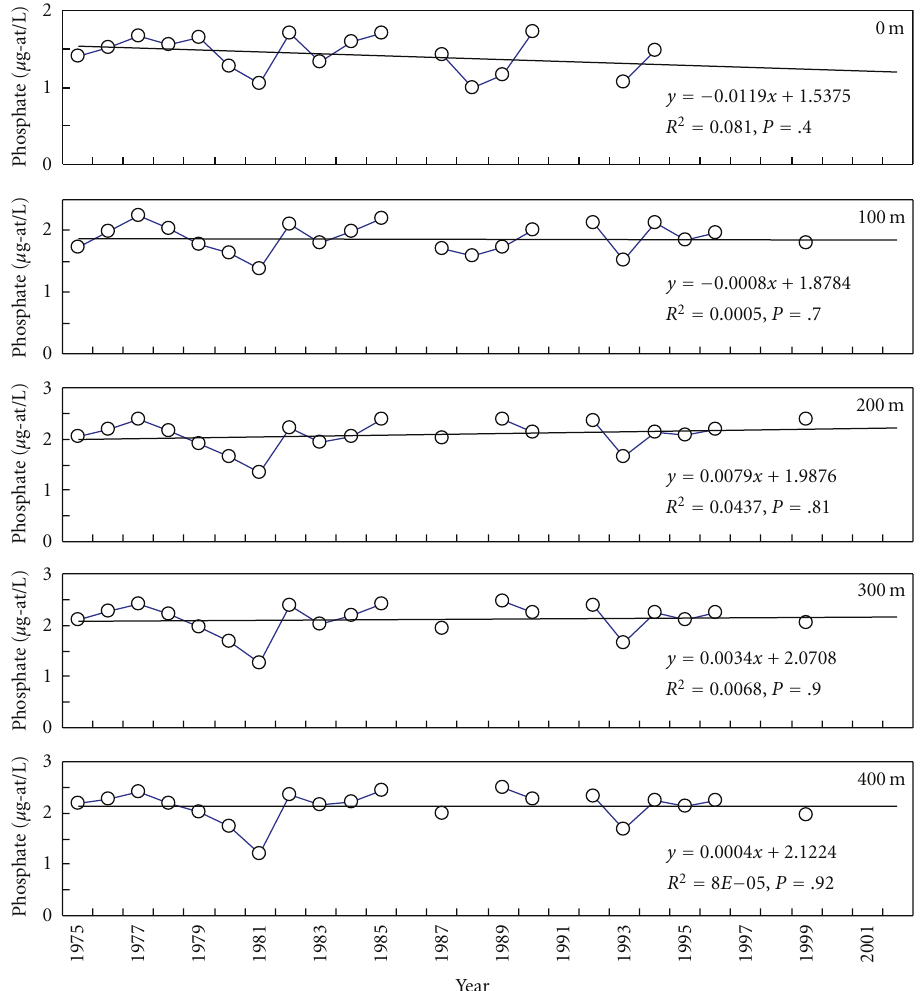
Figure 8: Long-term time series of the mean phosphate concentrations at the surface, 100 m, 200m, 300 m, and 400 m during austral summer (January–March) between 1975 and 2002. Solid lines represent linear